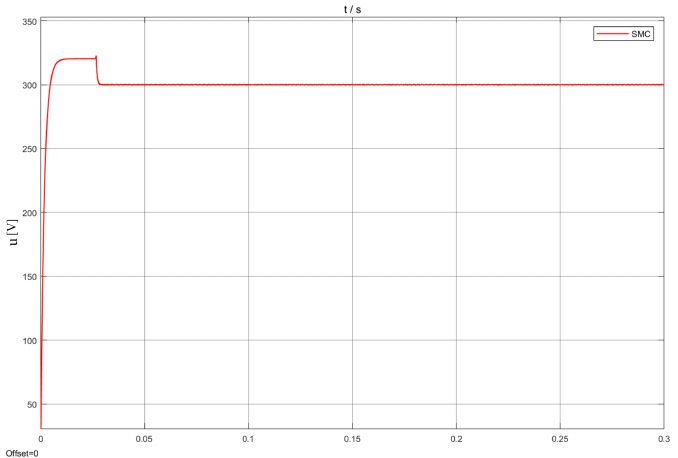
Figure 10. The output voltage waveform under the input voltage is 270 V.